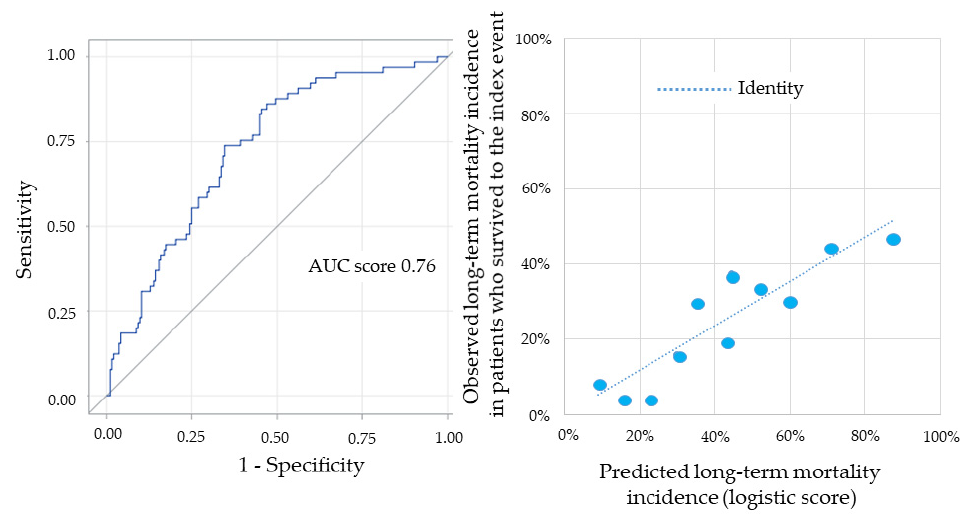
Figure 5. Left panel: receiving operating characteristic curve and corresponding area under the curve (AUC) for the risk score prediction of all-cause mortality following discharge from the index hospitalization. Right panel: concordance between the incidence of all-cause mortality following discharge from the index hospitalization predicted by the score and that observed in the entire population, stratified by deciles of risk.